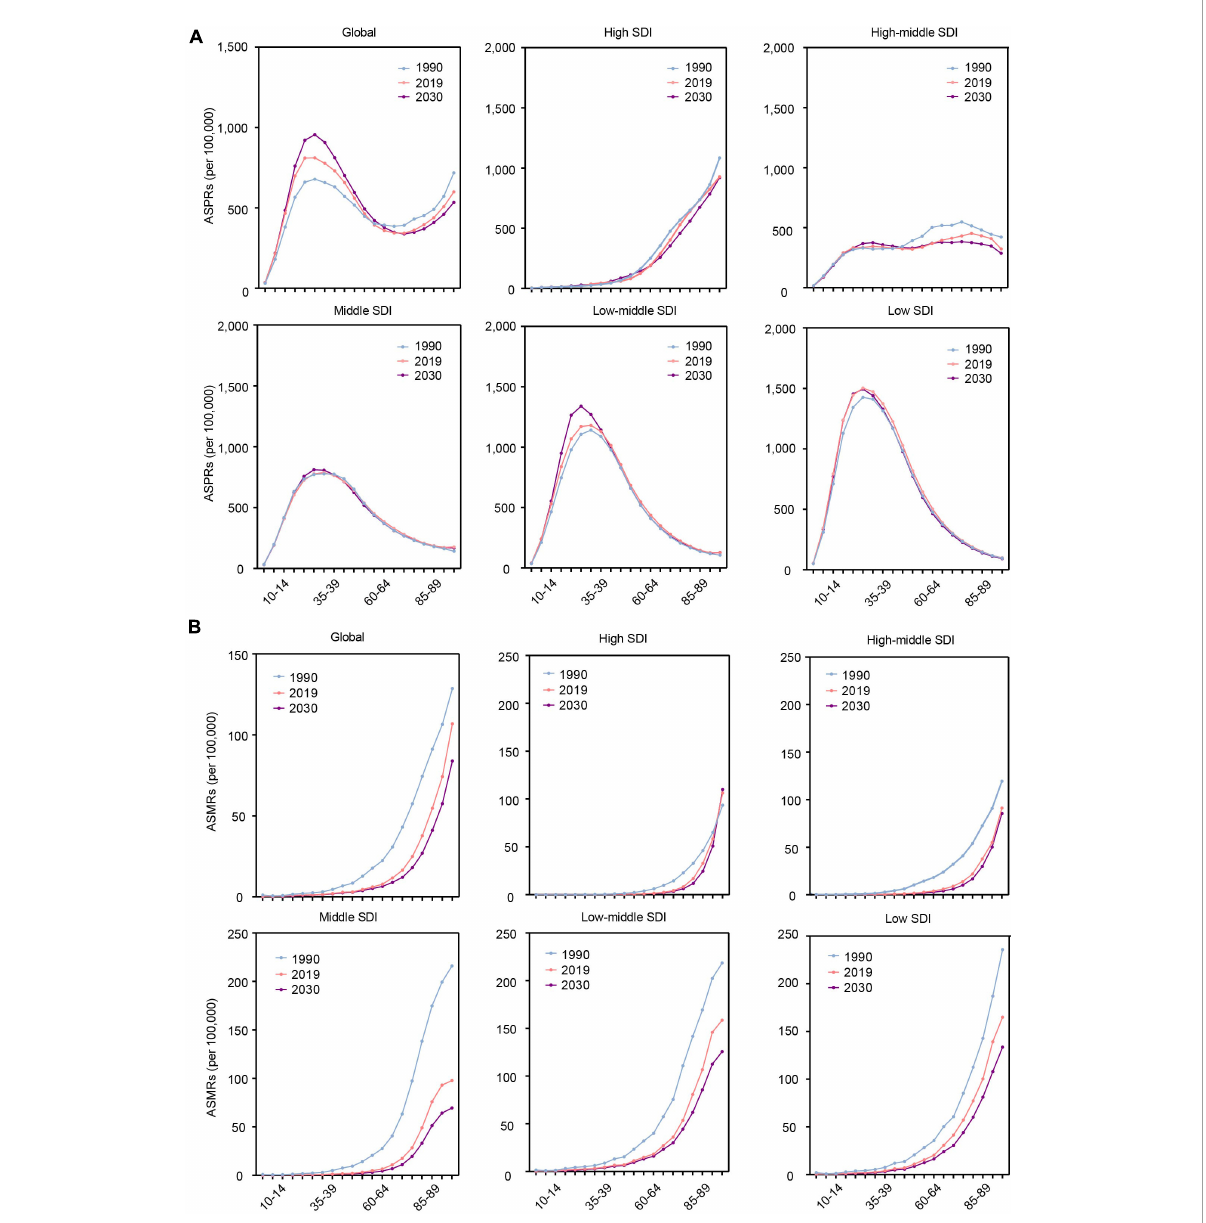
FIGURE4 The change trends of the RHD-related disease burden at the global level and in different SDI regions by age in 1990, 2019, and 2030. (A) The ASPRs. (B) The ASMRs. RHD, rheumatic heart disease; SDI, sociodemographic index; ASPRs, age-standardized prevalence rates; ASMRs, age-standardized mortality